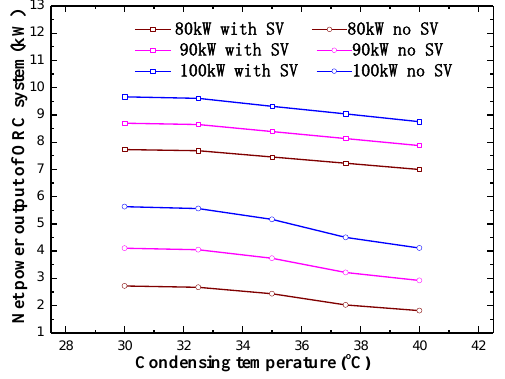
Figure 17. Net power output of ORC system vs. condensing temperature.